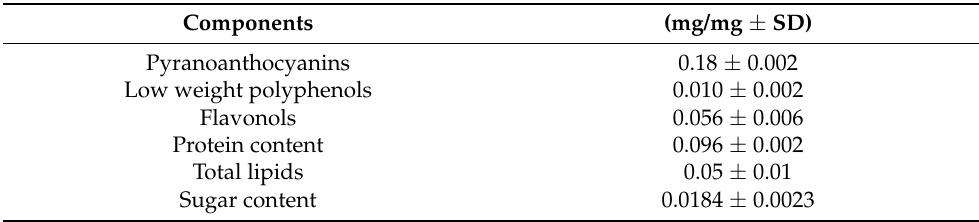
Table 2. Full composition of the carboxypyrano-ant